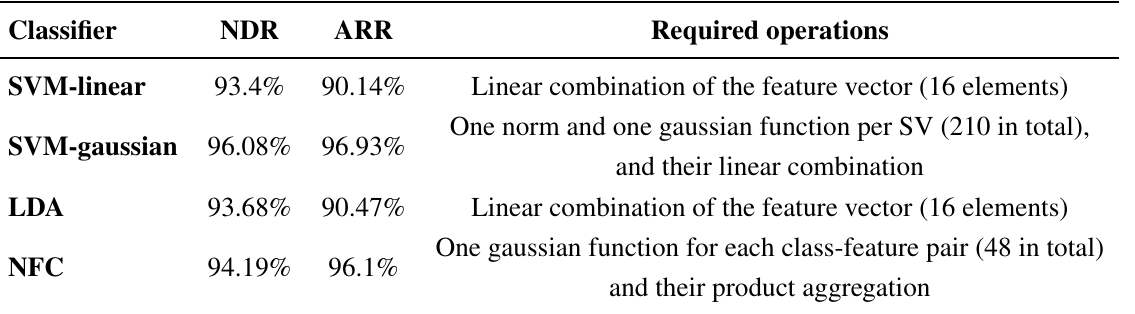
Table 5. Classification performance and number of parameters for different